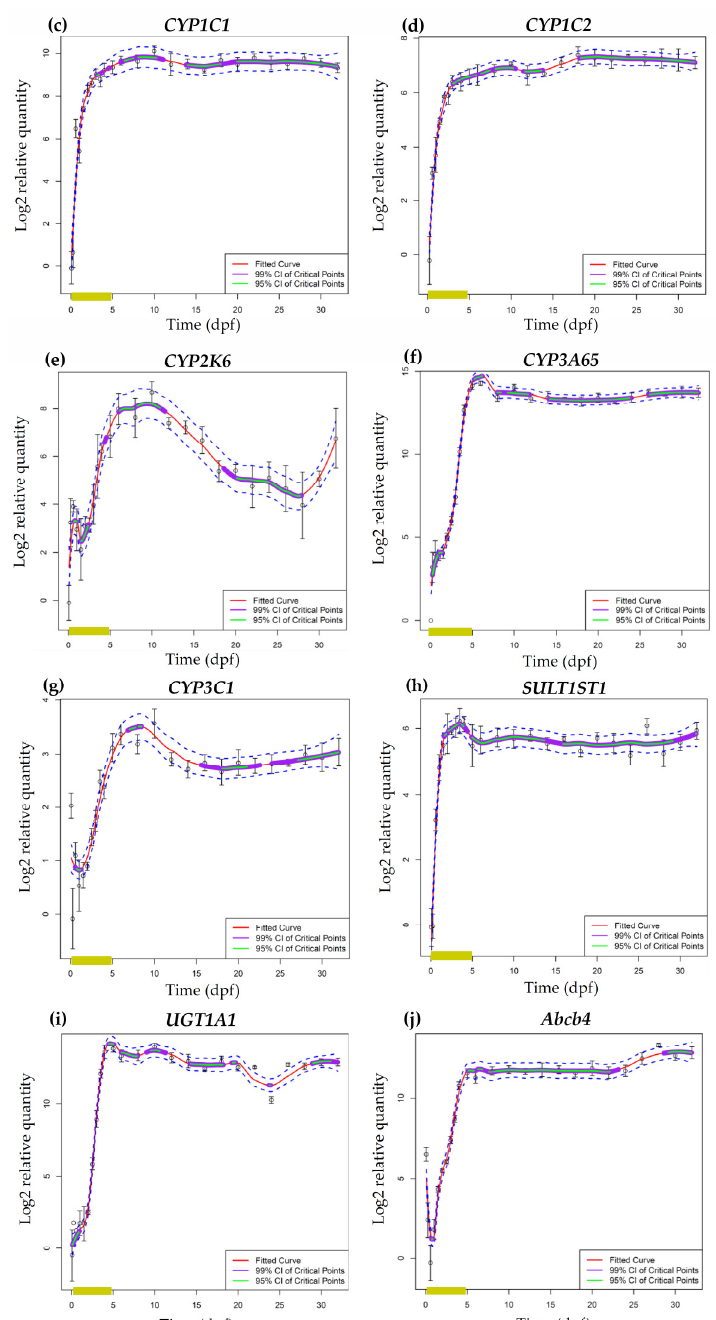
Figure 6. Relative quantities of cytochrome P450 (CYP) 1, 2 and 3 families from whole zebrafish bodies: ( a ) CYP1A , ( b ) CYP1B1 , ( c ) CYP1C1 , ( d ) CYP1C2 , ( e ) CYP2K6 , ( f ) CYP3A65 , ( g ) CYP3C1 and relative quantities of two phase II enzymes from whole zebrafish bodies, i.e., ( h ) sulfotransferase 1st1 ( SULT1ST1 ) and ( i ) uridine diphosphate glucuronosyltransferase 1A1 ( UGT1A1 ), and one P–glycoprotein, i.e., ( j ) ATP-binding cassette b4 ( abcb4 ) transporter. The graphs show log2 relative quantities which were normalized for reference gene expression and expressed relative to the time point with the lowest expression. Data points represent mean ± S.D. of four replicate pools at each time point (days post-fertilization (dpf)). The red line indicates the loess fit of the gene target and the surrounding dashed blue line indicates the 95% confidence interval around the loess fit. The green and purple highlighted regions represent the 95% and 99% confidence intervals, respectively, of each critical point (minimum or maximum) of mRNA expression. The color bar between 0 and 5 dpf, i.e., between 0 and 120 h post-fertilization, indicates the period of zebrafish